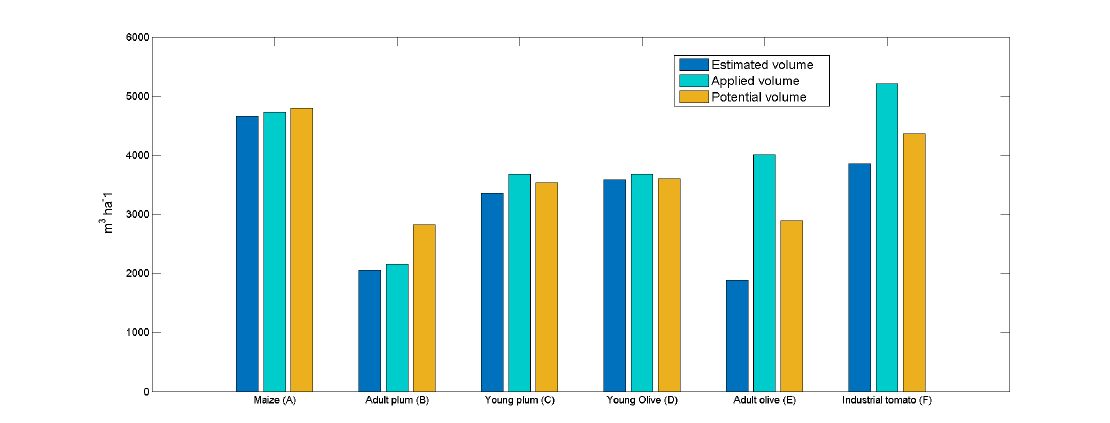
Figure 10. Estimated, applied, and potential water volumes for the orchards and annual crops selected for the evaluation of the